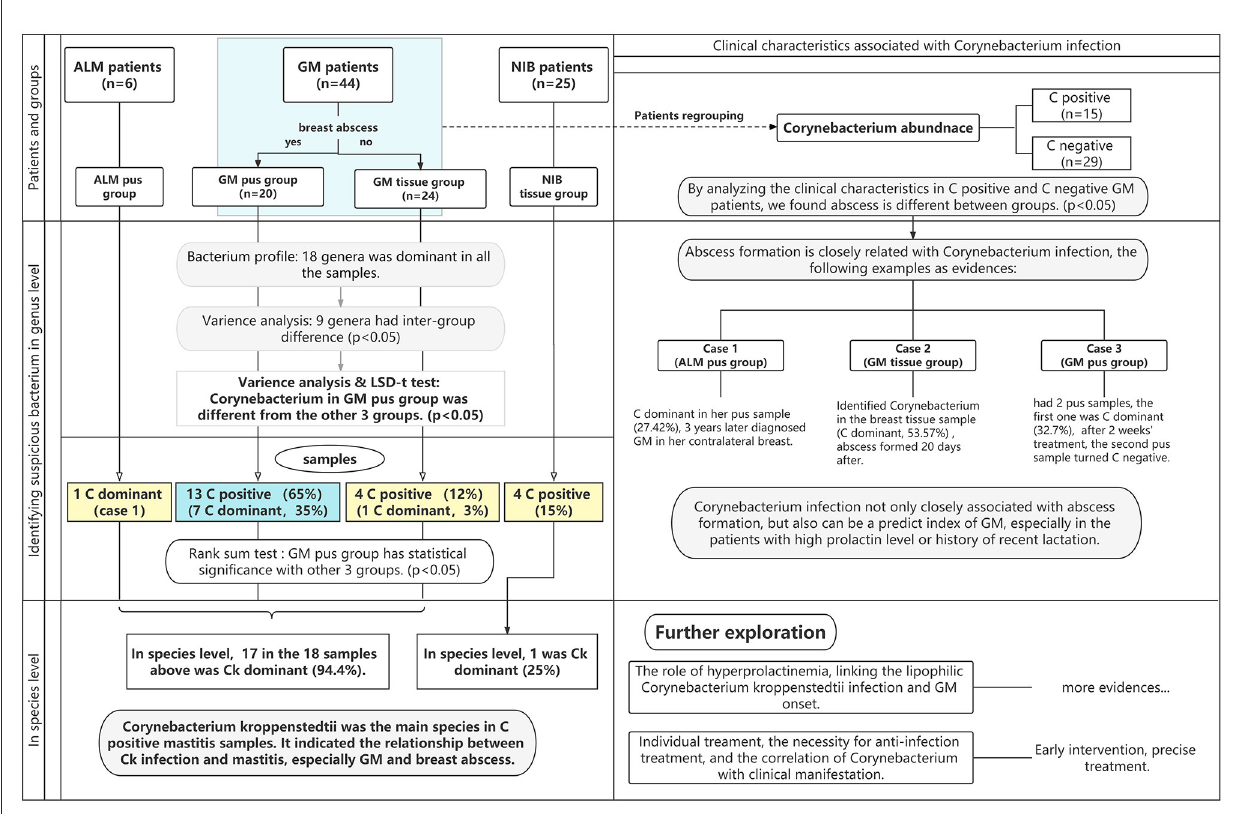
FIGURE1 The flowchart of this study. The blue area represents the observation group, while the yellow areas represent the control group. Abbreviations: ALM, acute lactation mastitis; Ck , Corynebacterium kroppenstedtii ; GM, granulomatous mastitis; NIB, non-inflammation breast disease. “C” is the abbreviation for Corynebacterium ; C-dominant means the abundance of Corynebacterium is > 10%, and C-positive means the abundance of Corynebacterium is >